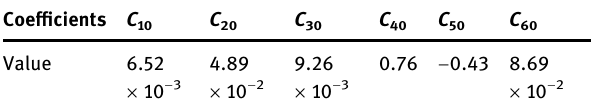
Table 2: Hyperelastic coe ffi cients of the artery